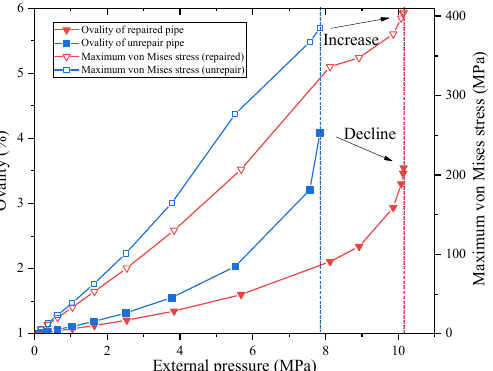
Figure 18. Variation of maximum stress and ovality with external pressure.